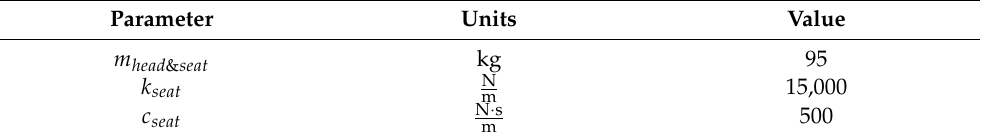
Table 3. Values of the parameters of the seat and human model in the three DOFs VSH model. Parameter Units